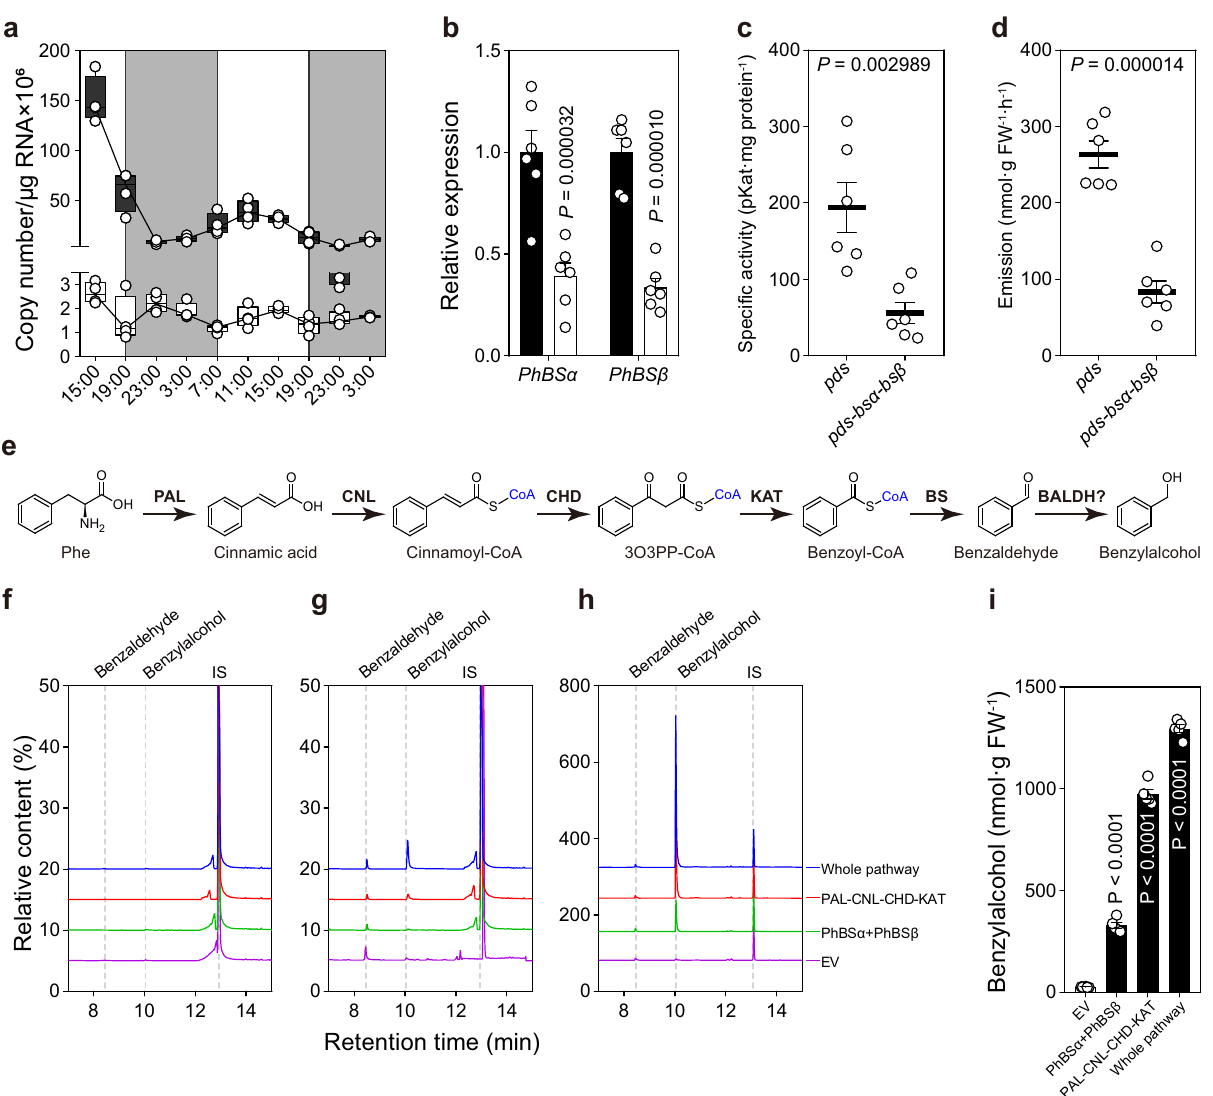
Fig. 5 Diurnal expression and function of PhBS in vivo. a Changes in PhBS α (black box) and PhBS β (white box) transcript levels during a normal light/dark cycle in petunia corolla harvested from day 1 post-anthesis (15:00) to day 3 post-anthesis (3:00). The PhBS α and PhBS β expression was determined by qRT-PCR with gene-speci fi c primers and expressed as a copy number of transcripts per microgram of total RNA × 10 6 . White and gray areas correspond to light and dark, respectively. Shown are box and whiskers plot ( n = 4 biological replicates), center line, median; box limits, upper and lower quartiles; whiskers, minimum and maximum. b – d Effect of PhBS downregulation on benzaldehyde emission. b Transcript levels of PhBS α and PhBS β in pds control (black bars) and pds-bs α -bs β (white bars) in 2-day-old VIGS fl owers at 21:00 h determined by qRT-PCR and presented relative to the corresponding levels in pds control set as 1. Data are means ± SE ( n = 6 biological replicates). P values were determined by two-way ANOVA multiple comparisons test